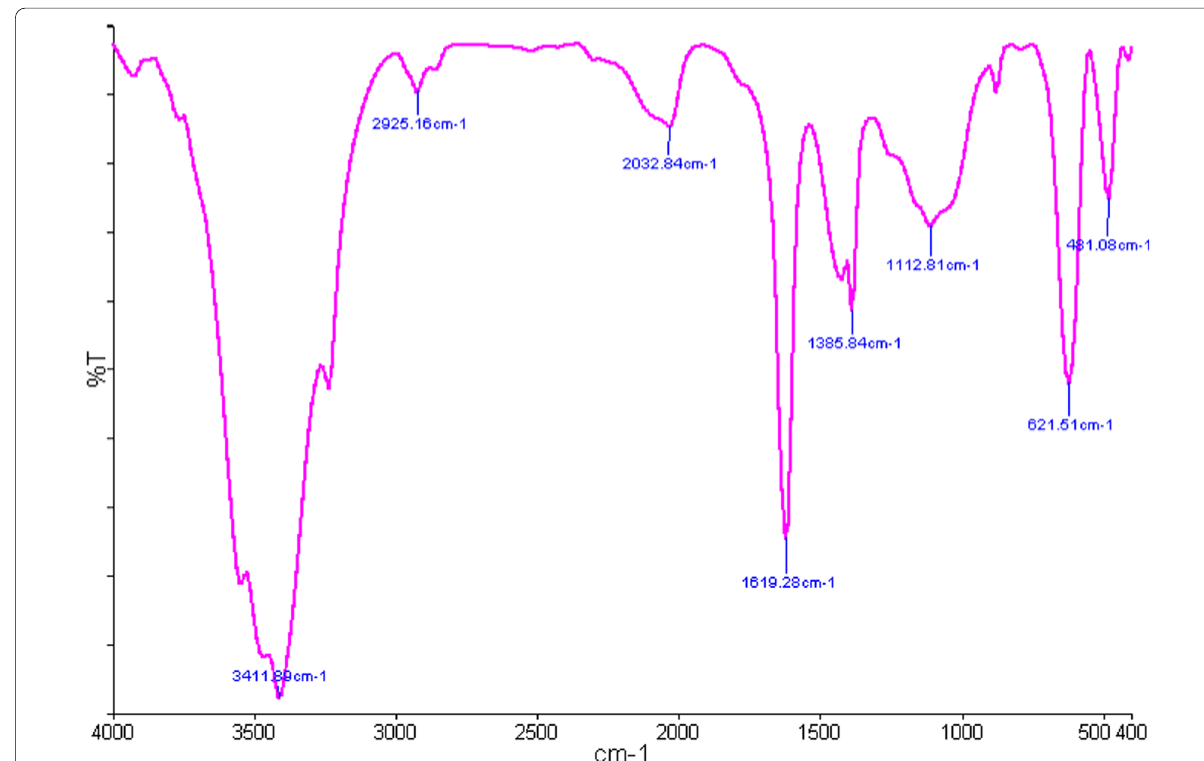
Fig. 4 The FTIR spectrum of the AgNPs synthesized by Juniperus polycarpos